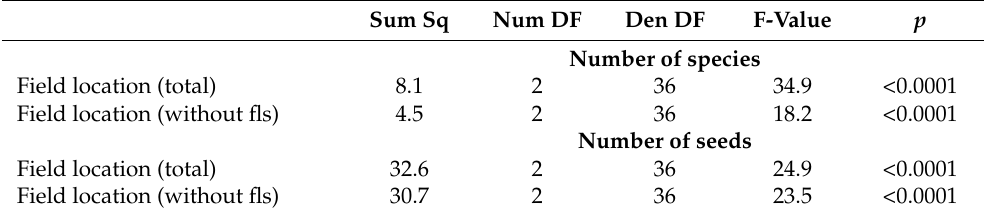
Table 2. ANOVA results of fixed effects of linear mixed models on differences according to field interior, field edge, and flower strip in the number of species and seeds present in the soil seed bank (fls: flower strip seed mixture